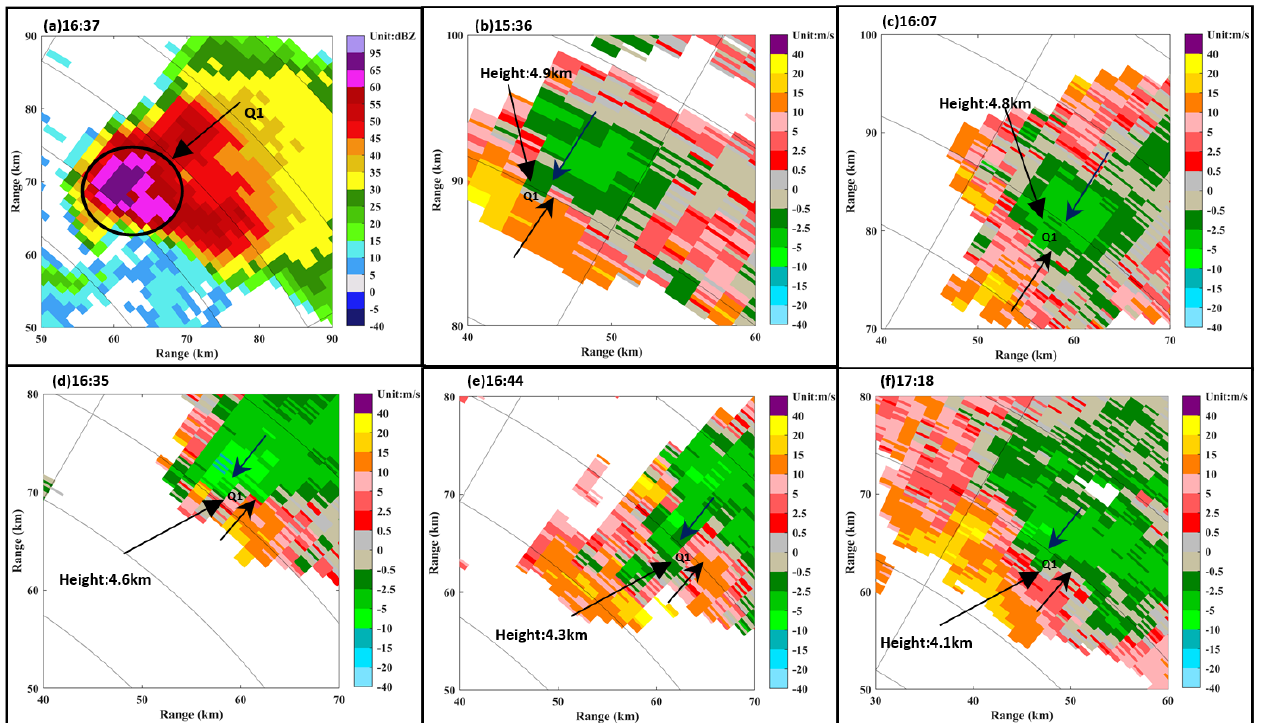
Figure 16 Figure 16. Radar echoes from Jinan, Shandong on 27 June 2009. ( a ) 16:37 is the reflectivity PPI at